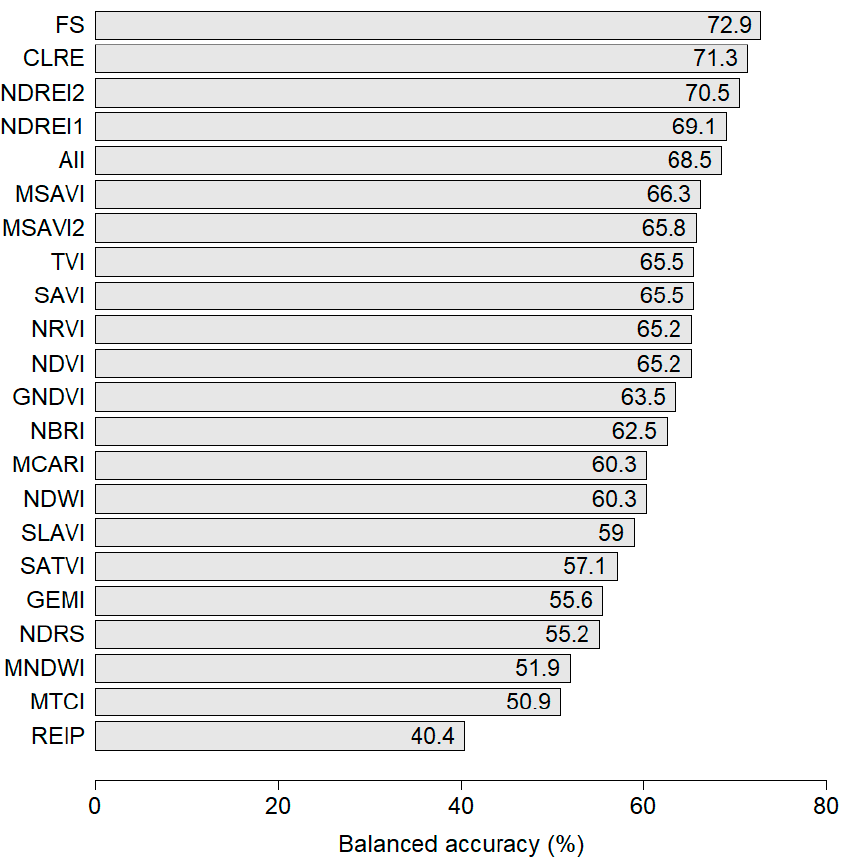
Figure 3. Balanced accuracy obtained with the 3-fold cross-validation for the bark beetle attack classification considering all the indices (“All”), the ones selected by the feature selection algorithm (“FS”), and each index independently.